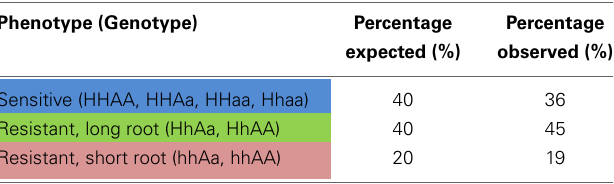
Table 2 | Segregation analysis of a selfing cross of the ABI3:HCC1 -complemented hemizygous hcc1